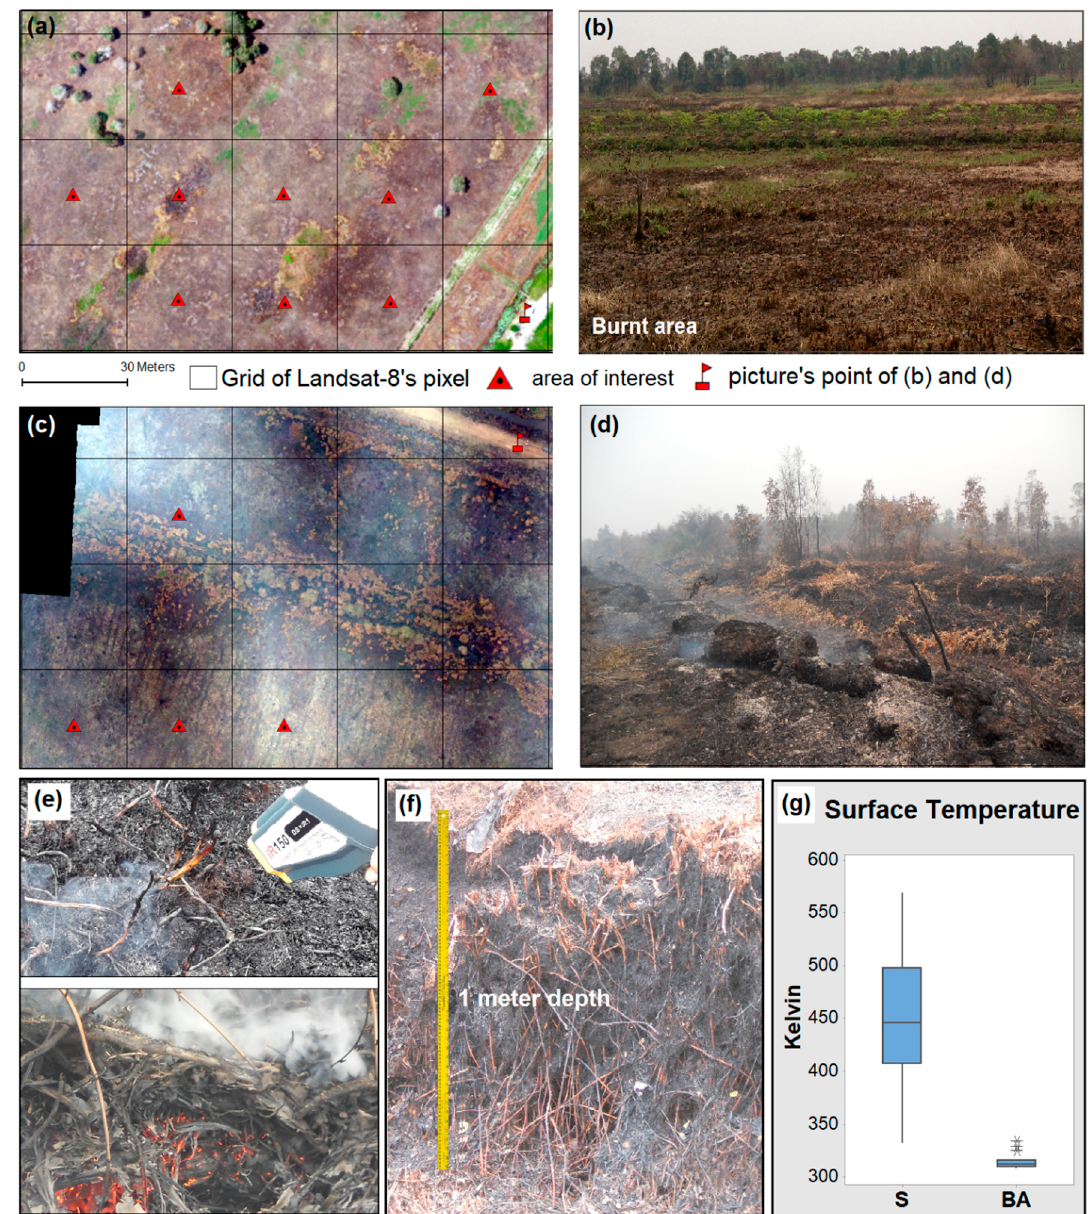
Figure 4. ( a ) Example of field picture taken from drone over burnt areas. The areas of interest were selected at homogenous pixels ( > 80–90% of pixel area of Landsat-8 was burnt area and smouldering peatland). Drone imaging was taken using Da-Jiang Innovations (DJI) Phantom Pro-4 on the same day with Landsat-8 acquisition (28 September 2018); ( b ) Picture of burnt area taken from the surface by digital camera in the burnt areas shown in Figure ( a ) at di ff erent orientation; ( c ) Example of smouldering peatlands taken by drone on 30 September 2018, two days after Landsat-8 acquisition time; ( d ) Picture of smouldering peatlands taken from surface in area of the smouldering peatlands in Figure (c) at di ff erent orientation; smoke shown from smouldering logs and surface peatlands; ( e ) Measurement of surface temperature on smouldering peatland using handheld IRtek IR150 dual-beam laser infrared thermometer; smouldering features below the peatland surface (to − 20 cm) with smoke at the surface; ( f ) An example of peatland depth (1 m) consists of decaying roots and organic soil as the fuels for smouldering peatland; ( g ) Boxplots of smouldering (S) peatland and burnt area temperatures at the surface from 44 smouldering locations and 16 burnt area (BA) locations.